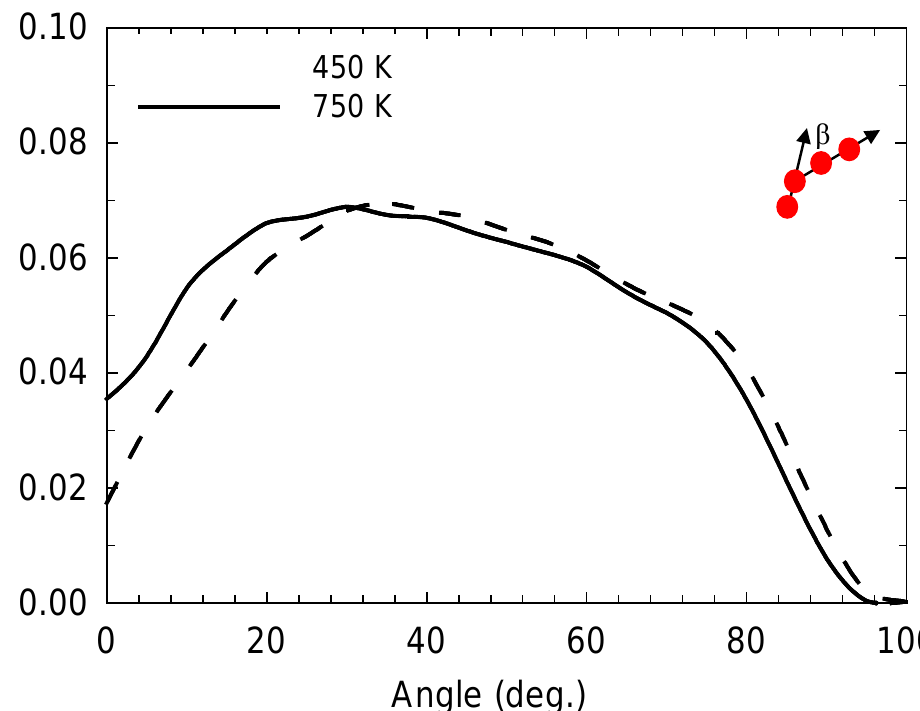
Figure 1. Normalised approach-angle (β) [24] distribution at 450 and 750 K; β (depicted schematically) is the angle with respect to the I 3– I – collinear axis [24].